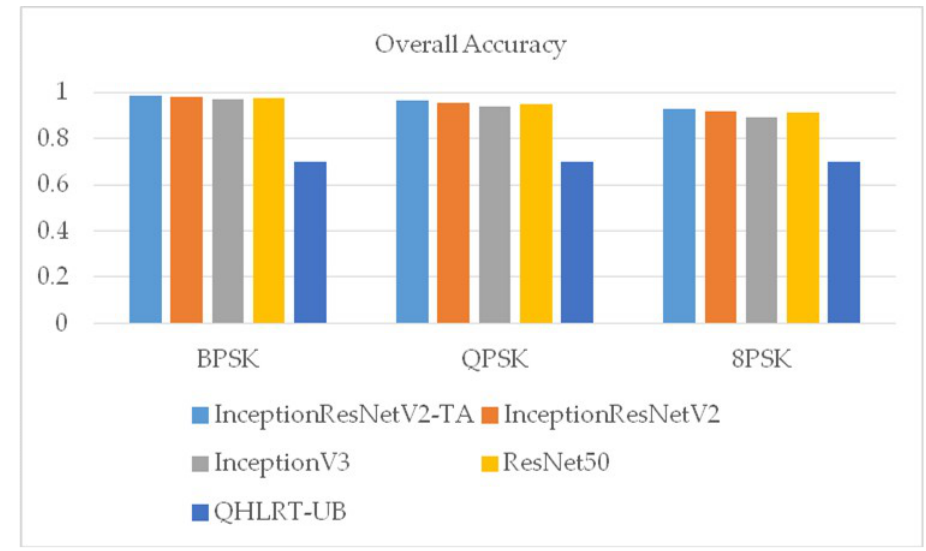
Figure 9. Overall recognition rates for the three signals.